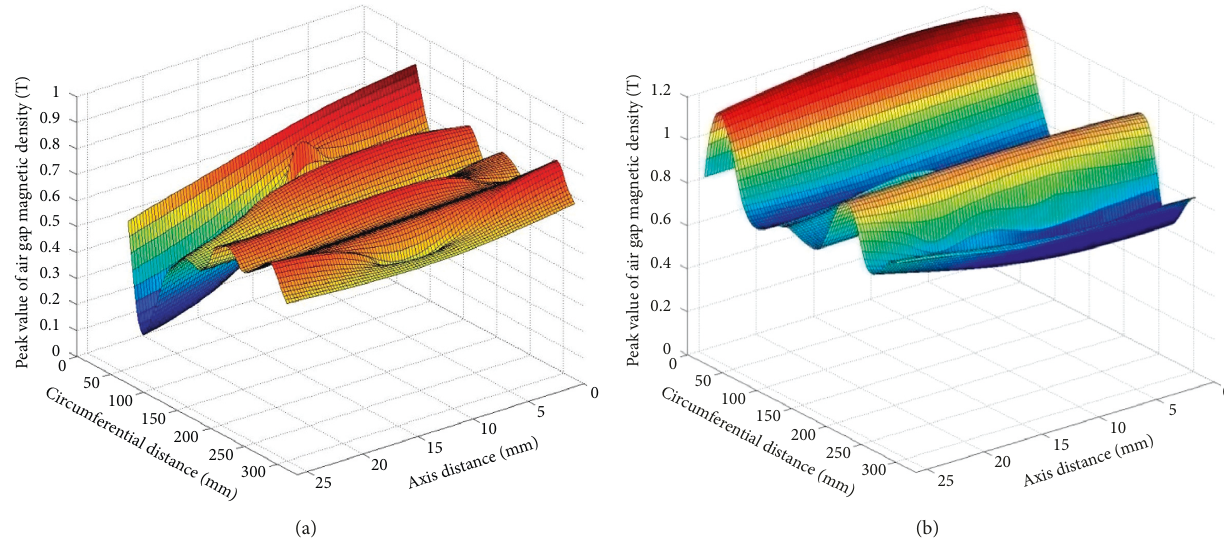
Figure 10: Comparison results of peak value of air gap magnetic density. (a) The peak value of air gap magnetic density before optimization. (b) The peak value of air gap magnetic density after